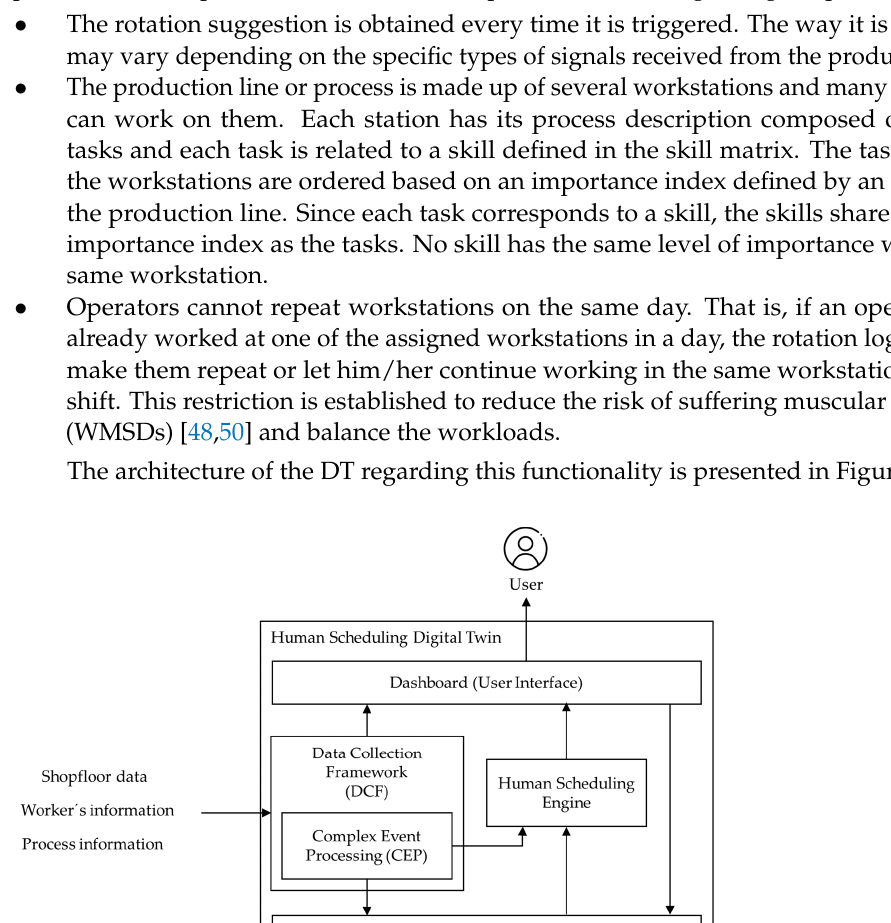
Figure 2. Knowledge-based representation of the described case.